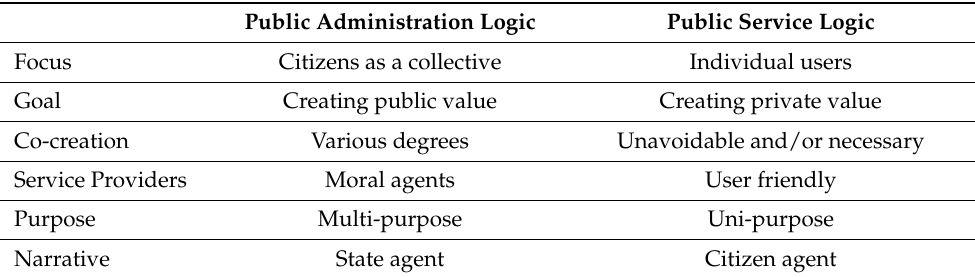
Table 1. Differences between public administration logic and public service